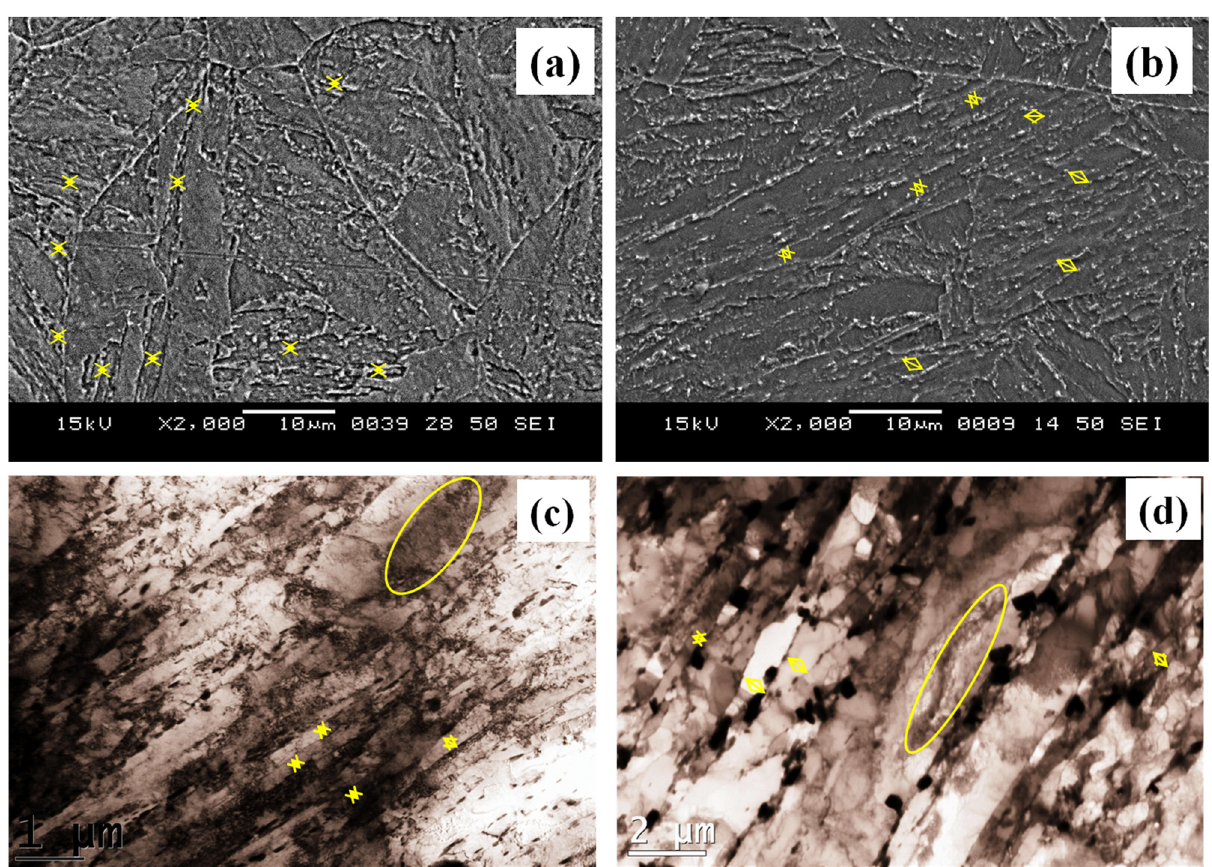
Figure 7: Reduction in dislocation density and increase in lath width observed for 1060°C/740°C ( a and c ) after heat treatment ( b and d ) after creep rupture for 250 MPa/2,509 h ( markings indicate lath width, enclosed area indicates dislocation density [ qualitative ])